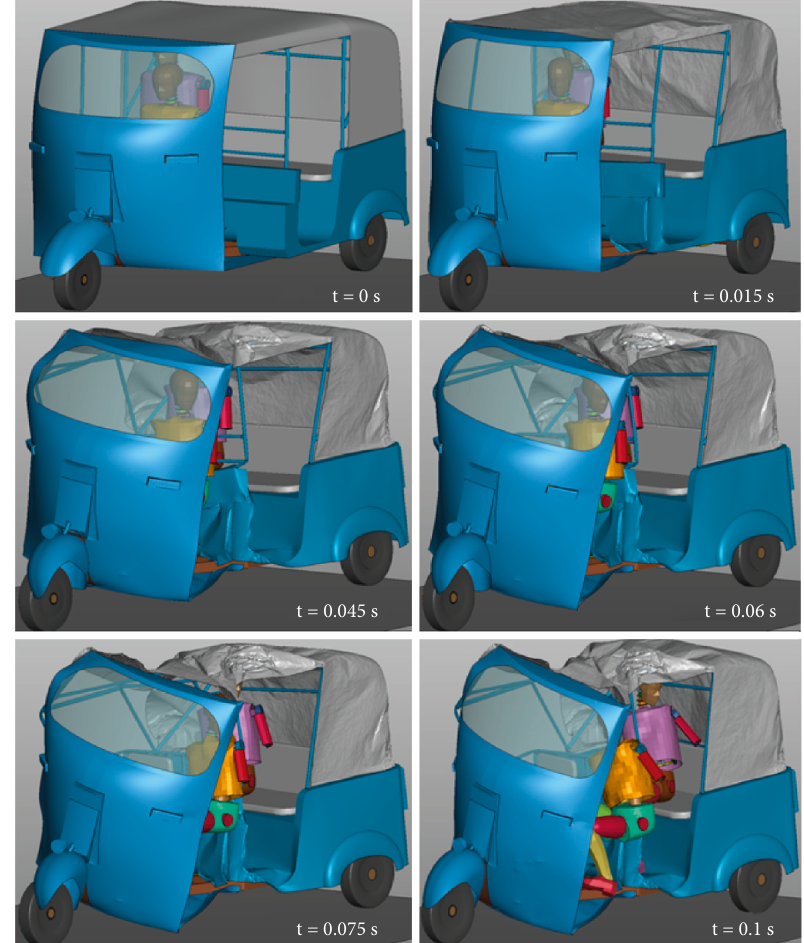
Figure 16: Side crash sequence.